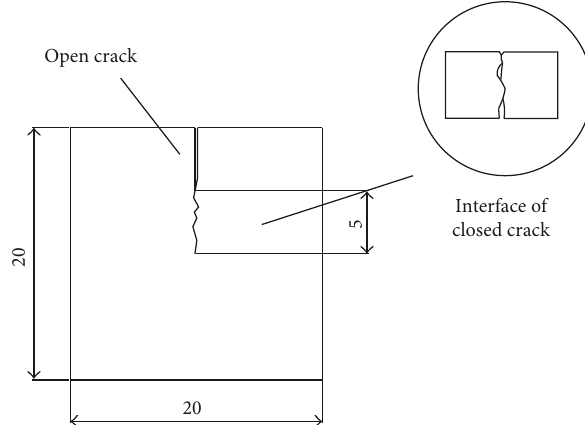
Figure 8: Morphology of the crack (Unit: